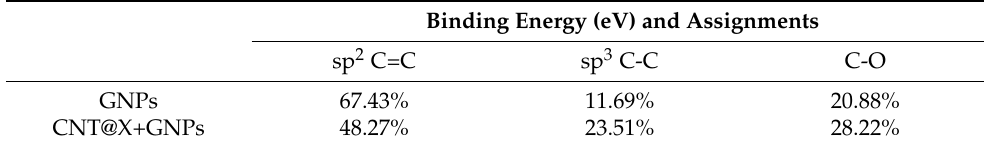
Table 3. Related percentages of carbon assignments from C 1s